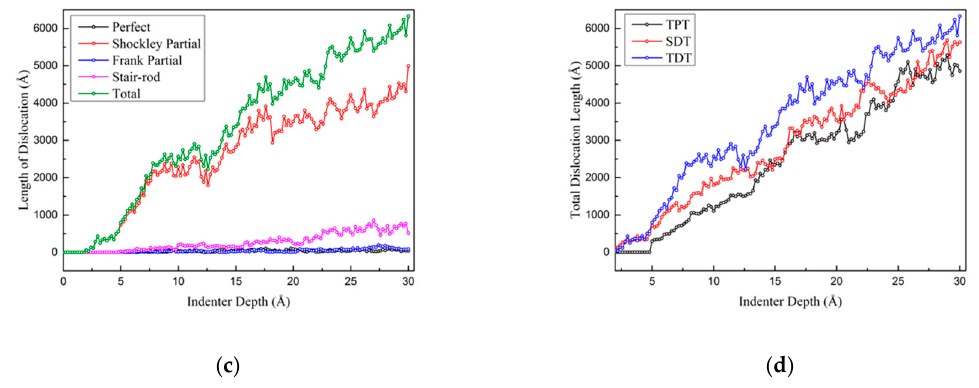
Figure 12. Dislocation length change of three different models. ( a ) TPT; ( b ) SDT; ( c ) TDT; ( d ) Total dislocation lengths of three models.